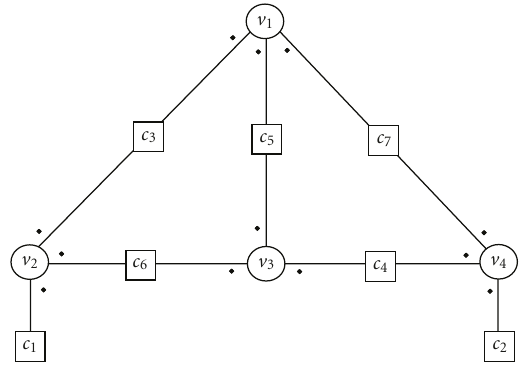
Figure 3: Trapping set example of T (4,2).